Question: What caption would you write for this figure?
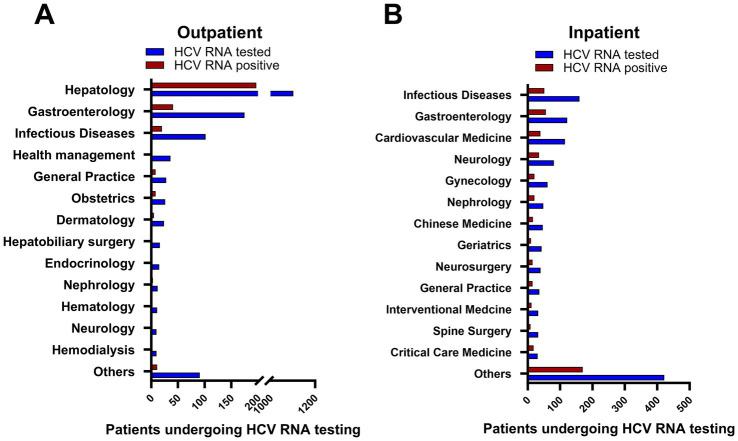
Answer: Distribution of HCV RNA testing and RNA-positive cases across clinical departments. (A) Outpatient setting and (B) inpatient setting. Blue bars represent the number of patients undergoing HCV RNA testing, and red bars represent the number of patients with confirmed HCV RNA positivity. The “Others” category includes departments with relatively small numbers of tested patients and was combined for visualization purposes. A broken x-axis was applied in panel A because of the substantially larger number of patients from the Hepatology Department.